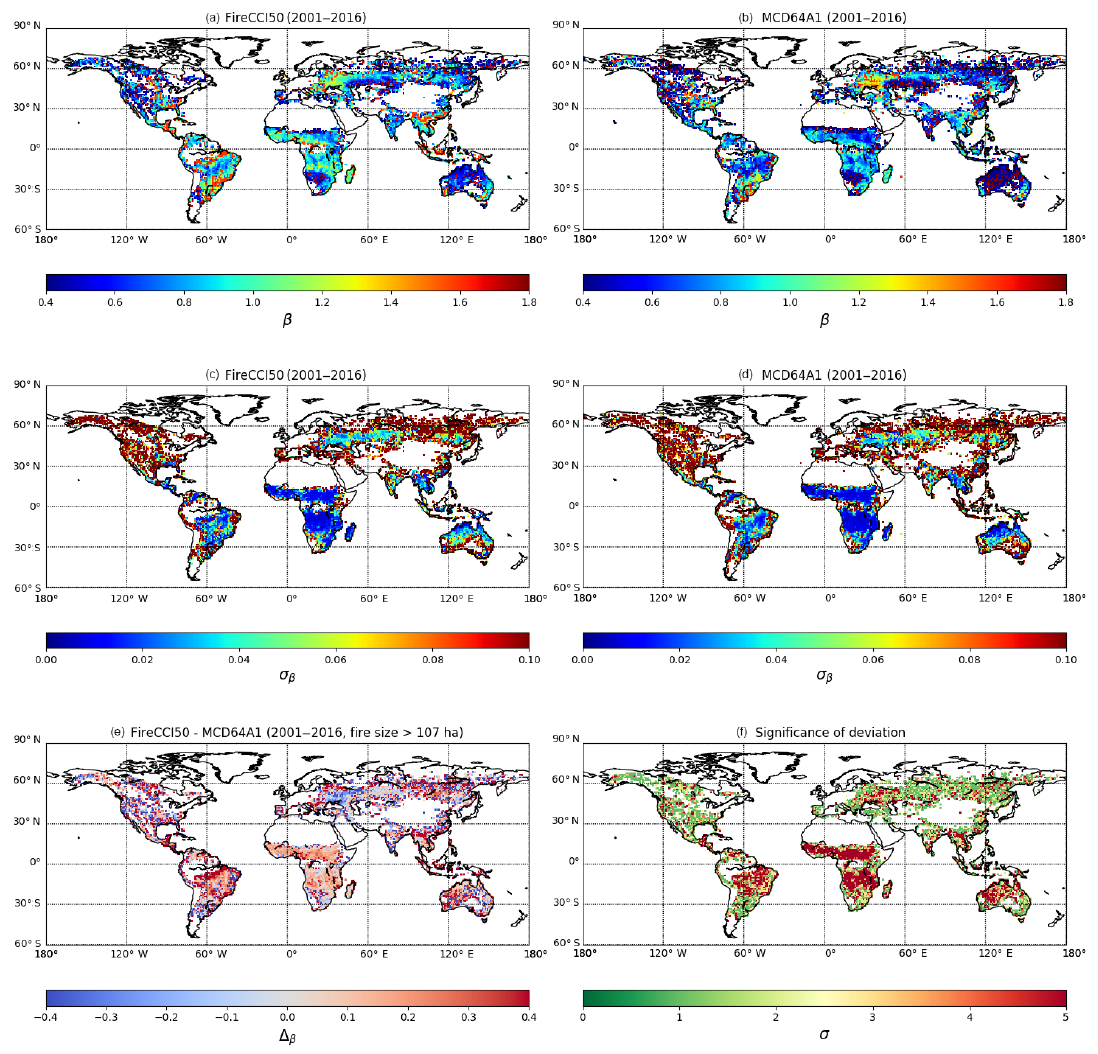
Figure 9. Slope ( β ) of the fire number–fire size relationship (log scale) and its uncertainty ( σ ) for FireCCI50 (a, c) and MCD64A1 c6 (b, d) . The difference between the two products is also presented (e) , with the level of agreement between the two products (f)